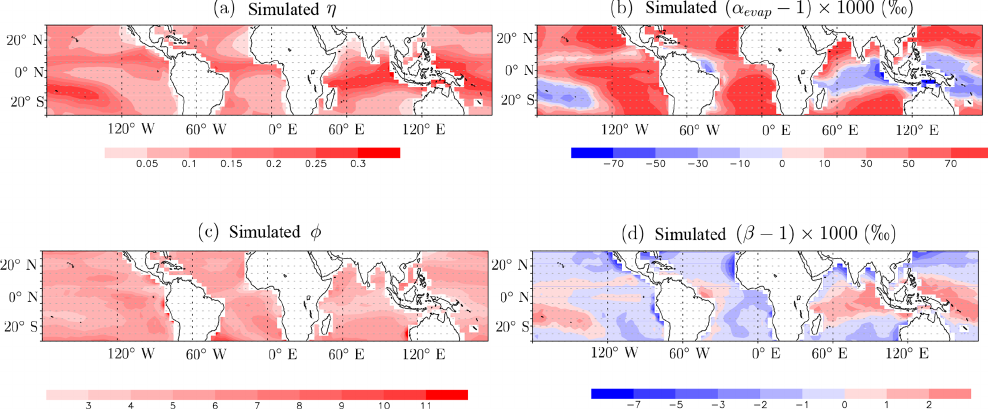
Figure C1. (a) Ratio η of water in the SCL coming from rain evaporation to that coming from surface evaporation. (b) Effective fractionation coefficient α evap between the SCL water vapor and the rain evaporation. (c) Ratio φ of water in the SCL coming from horizontal advection to that coming from surface evaporation. (d) Effective fractionation coefficient β between the SCL water vapor and the water vapor coming from horizontal